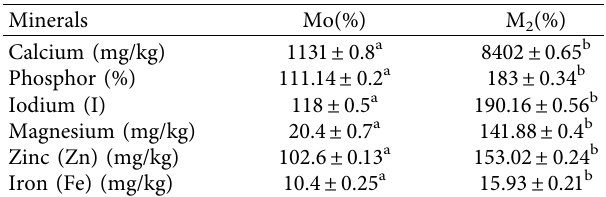
Table 4: The mineral content of 8% fortified sago noodles in fish